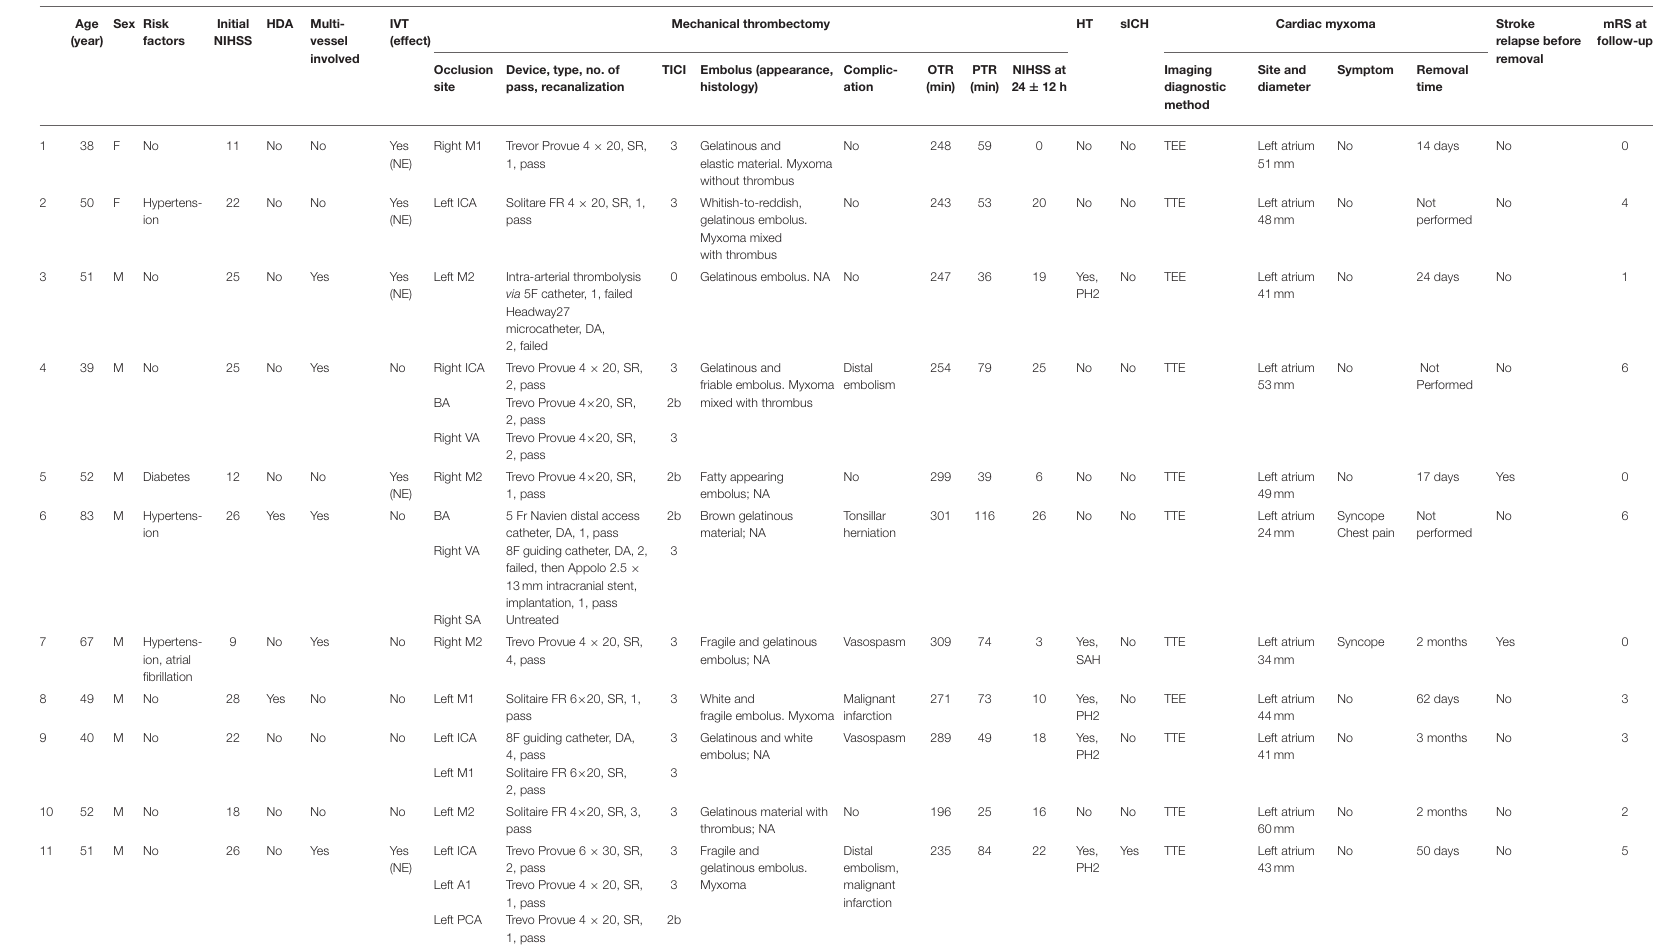
TABLE 1 | Characteristics of CM-AIS patients who underwent mechanical